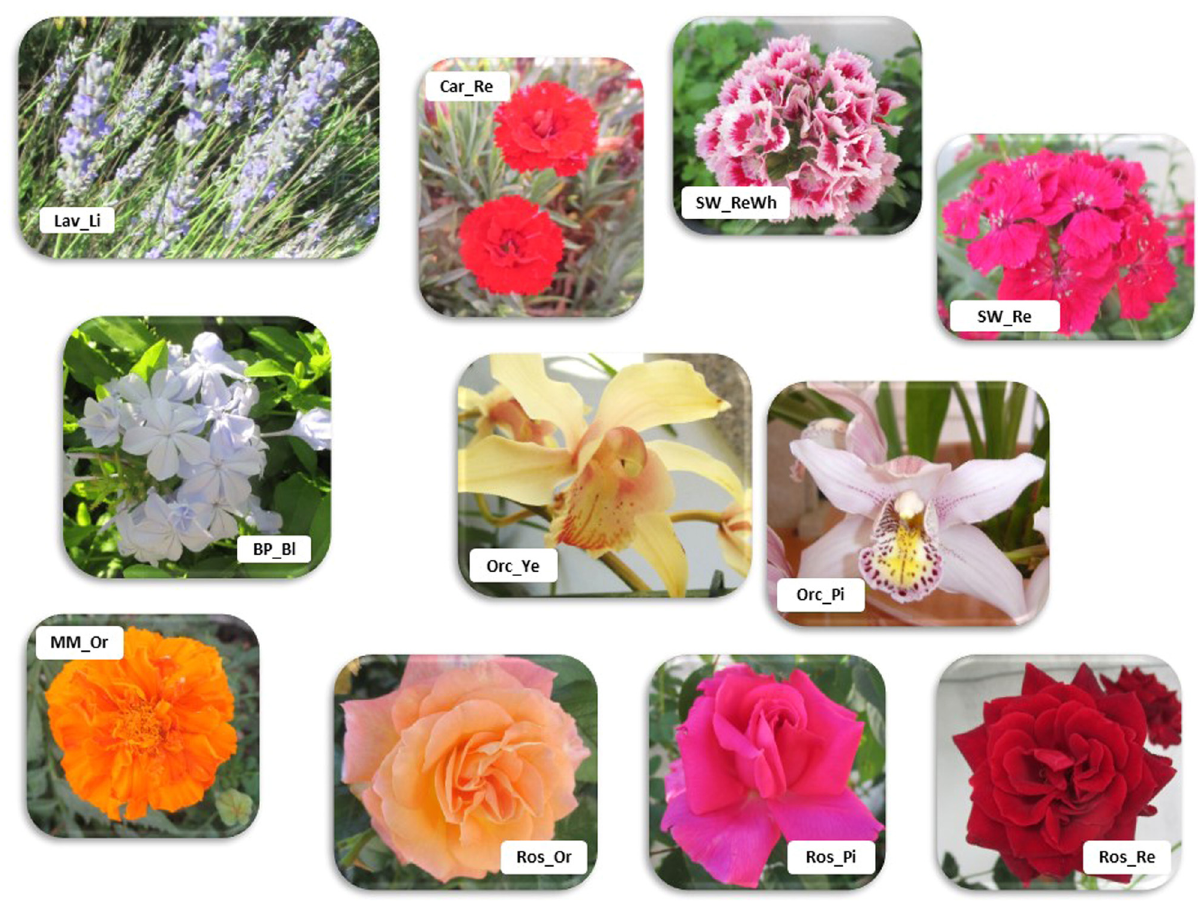
Figure 1: Photos of the fl owers used in the